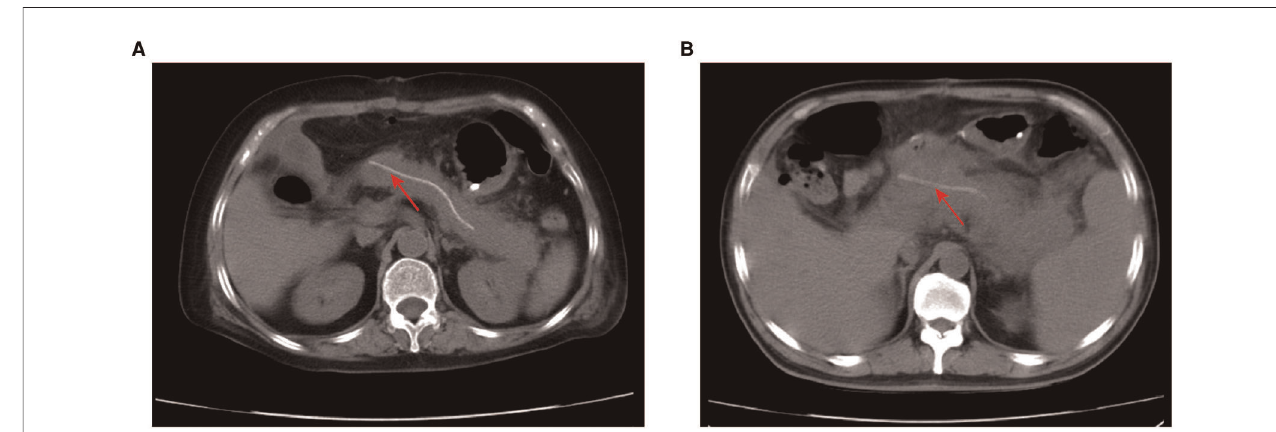
FIGURE 1 | Postoperative CT scans of PPAP. ( A ) Acute edematous pancreatitis after PD: the boundary of the remnant pancreas is coarse, extensive exudation and in fl ammatory change around the remnant pancreas, not the surgical fi eld. ( B ). Acute necrotizing pancreatitis after PD: the borderline of remnant pancreas is not distinct, in fl ammatory changes and exudate surrounding the remnant pancreas, necrosis change in the pancreatic parenchyma and the peripancreatic tissue. Red arrow: internal pancreatic duct stent. PPAP, postoperative acute pancreatitis; PD,